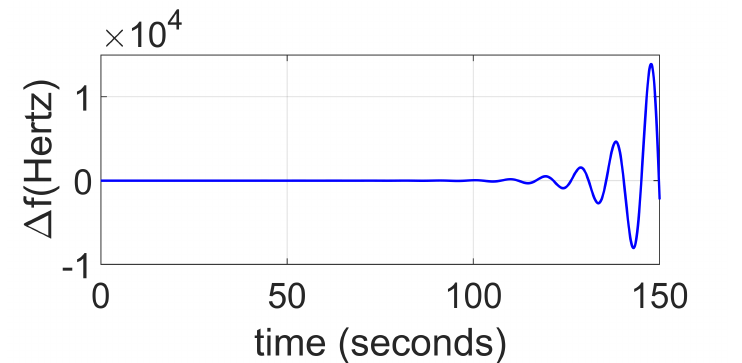
Figure 9. Frequency measurement under time delay